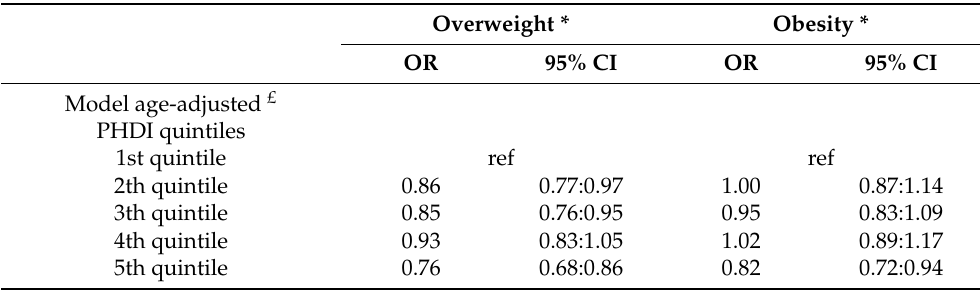
Table 3. Multiple multinomial logistic regression between Planetary Health Diet Index and over- weight and obesity. ELSA-Brasil,